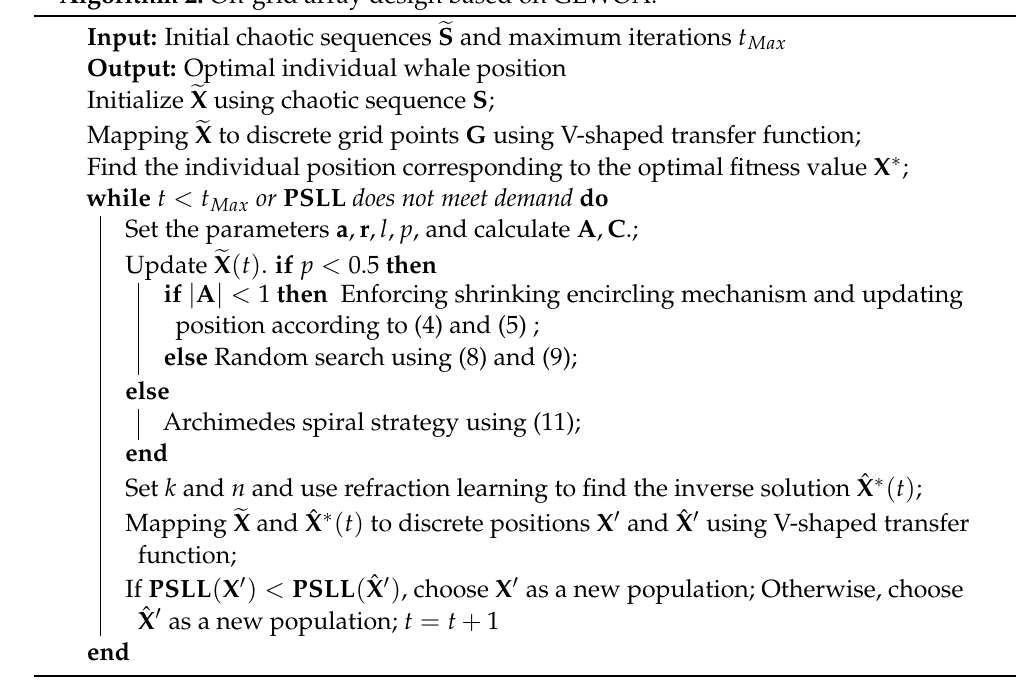
Algorithm 2: On-grid array design based on